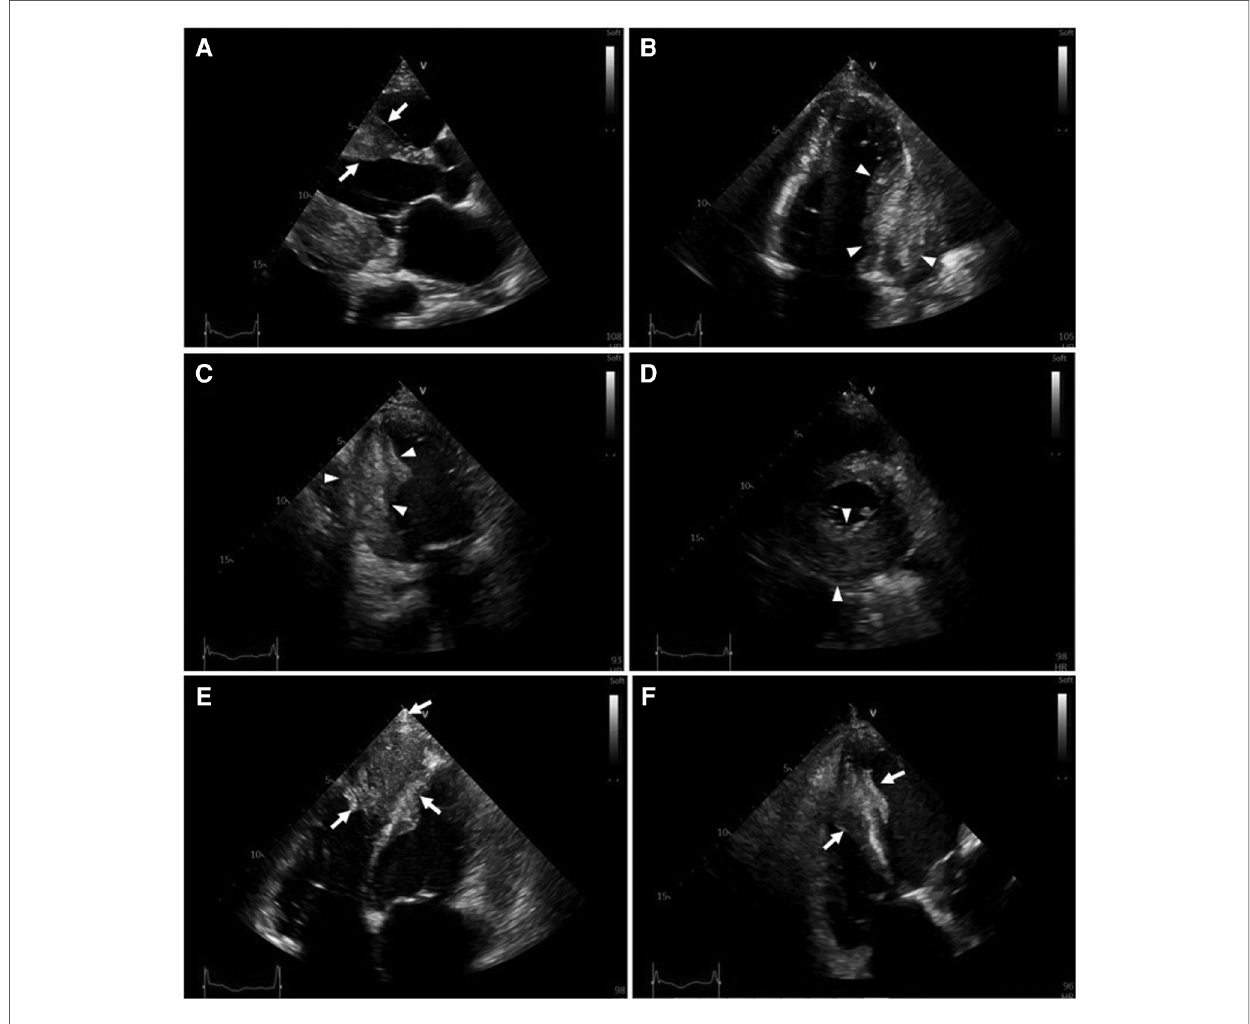
FIGURE 2 Transthoracic two-dimensional echocardiography (2D-TTE). 2D-TTE reveals two large heterogeneous masses characterized by ill-de fi ned borders: one involving the lateral, inferior and posterior portions of the left ventricular wall (white arrowheads) , and another involving the apex and ventricular septum (white arrows) . ( A) Parasternal long-axis view. ( B) Four-chamber view. ( C) Two-chamber view. ( D) Parasternal short-axis view at the papillary muscle level. ( E) Modi fi ed four-chamber view. ( F) RV-focused apical four-chamber